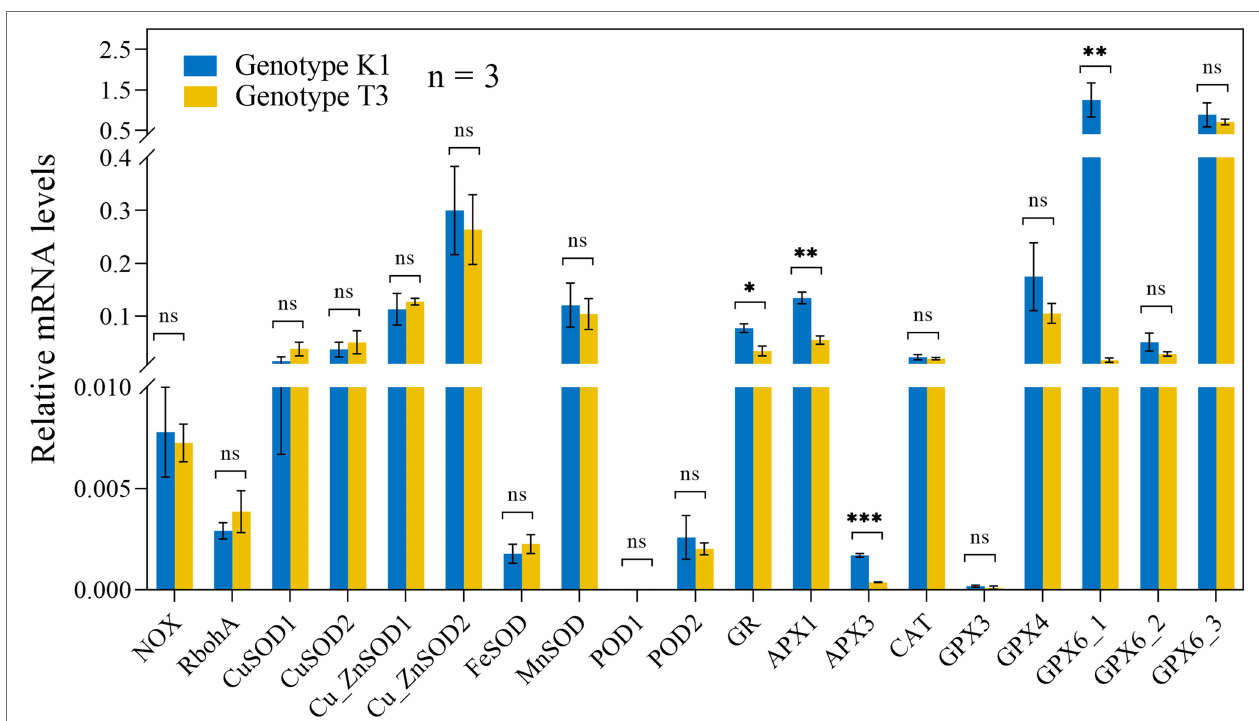
FIGURE 6 | Relative expression levels of genes involved in H 2 O 2 production and scavenging in leaves of Kreuzkogel 1 (K1) and Tenno 3 (T3) without B. cinerea inoculation were measured via qRT-PCR. All values were normalized to the expression level of the H4 and UBC9 housekeeping genes. Significant differences between two genotypes, based on the Wilcox test, are represented by ns p > 0.05, * p < 0.05, ** p < 0.01 and *** p < 0.001. NOX, NADPH OXIDASE; RBOHA, RESPIRATORY BURST OXIDASE HOMOLOGS; SOD, SUPEROXIDE DISMUTASE; CAT, CATALASE; POD, PEROXIDASE; GR, GLUTATHIONE REDUCTASE; APX: ASCORBATE PEROXIDASE, GPX, GLUTATHIONE PEROXIDASE